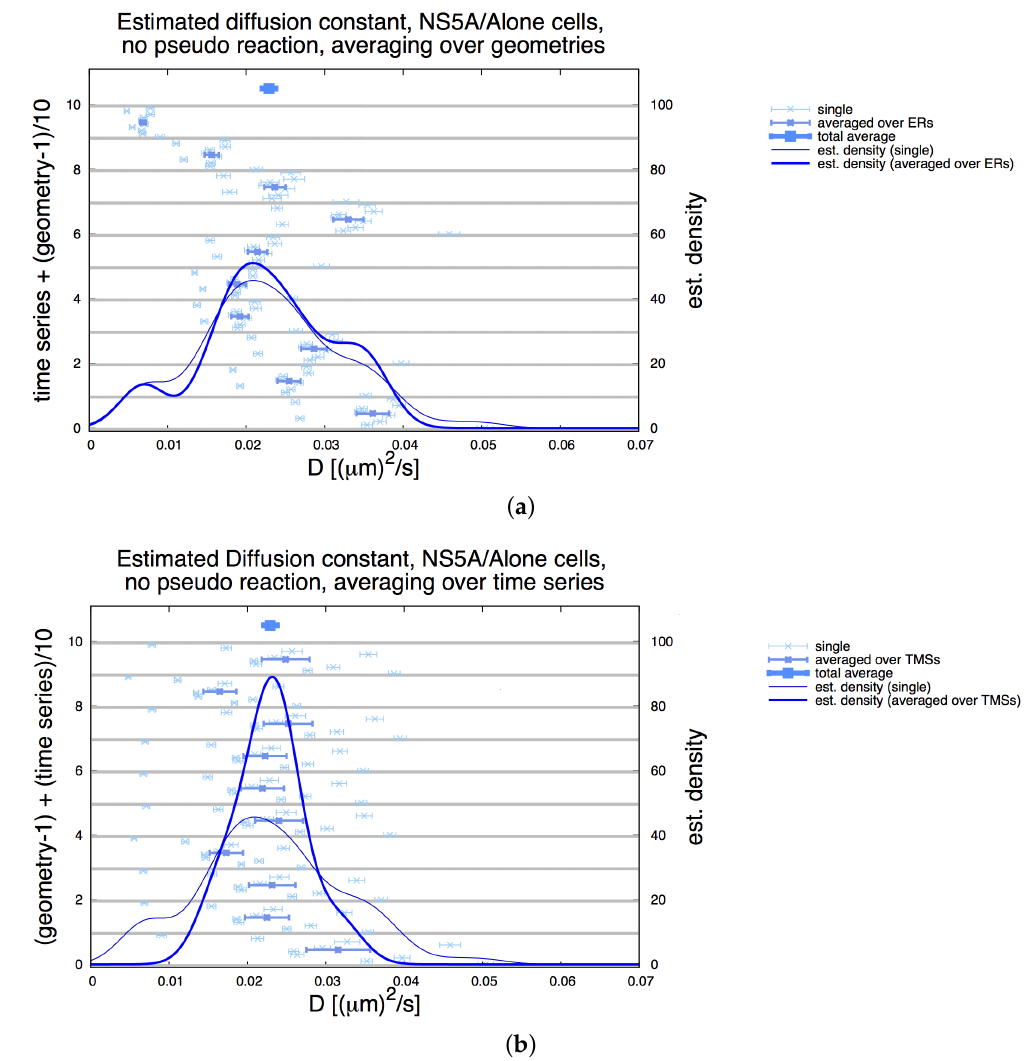
Figure A3. Averages for NS5A diffusion constant D A estimation on the ER surface as described ns5a in Sections 2.2 and 3.3 for the NS5A/Alone cell case, neglecting the measurement process induced signal reduction, i.e., setting r A p = 0 in (8). Simular analysis as in Figure 7. Thin points and error bars correspond for ( a , b ) to estimated values for D ns5a (shown on x axis) for the combination of single TMS with single geometries (indicated on the left y axis, note different combinations for geometry and TMS). Aggregating over all TMS and ER geometries yields distributions (thin continuous lines, scale shown on right y axis) which are identical in both cases. ( a ) Each “row” corresponds to one time series combined with all ER geometries. (For example, the left y axis value 2.5 corresponds to the combination of TMS # 2 and ER geometry E 6 ). Half thick symbols (shown in the middle of each time series region) correspond to the averaged values over all geometries D ns5a | G for the respective TMS. Aggregating these averages over all TMS yields distributions (thick continuous lines, scale shown on right y axis). Thick symbols (shown on top) correspond to the averaged values D ns5a . ( a ) Each “row” corresponds to one ER geometry combined with all TMS. (For example, the left y value 2.5 corresponds to ER geometry E 3 and TMS # 5). Half thick symbols (shown in the middle of each ER geometry region) correspond to the averaged values over all TMS D ns5a | T for the respective ER geometry as reported in Section 2.6. Aggregating these averages over all ER geometries yields distributions (thick continuous lines, scale shown on right y axis). Thick symbols (shown on top) correspond to the averaged values D A ns5a . Note: The total averages are identical for ( a , b ) and are reported in Table